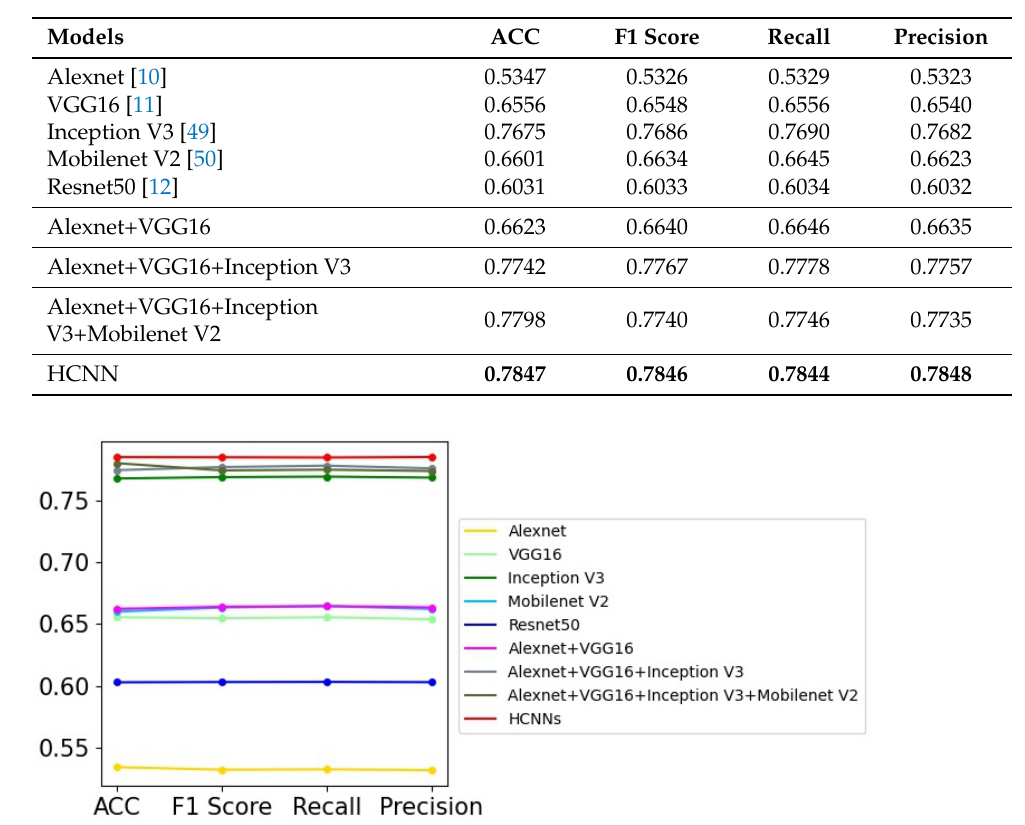
Table 6. The ablation analysis on the CIFAR-100 dataset.